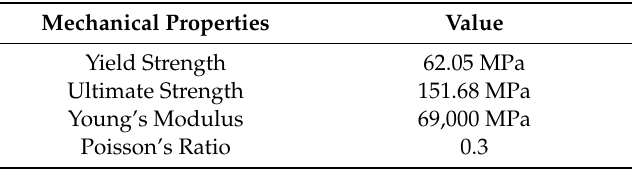
Table 1. Mechanical properties of the 6061 aluminum alloy.